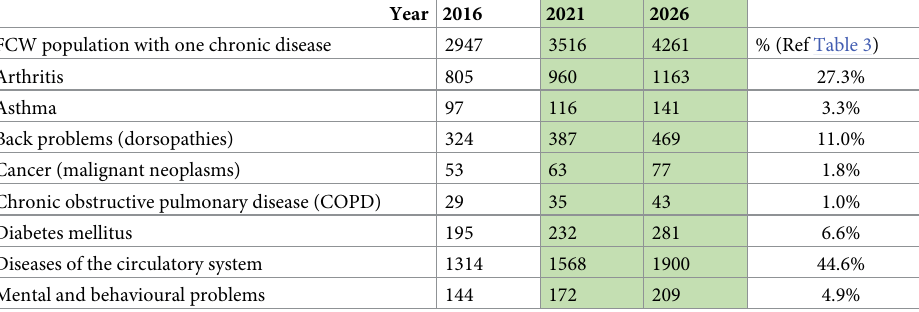
Table 9. Breakdown of FCW elderly population with one chronic